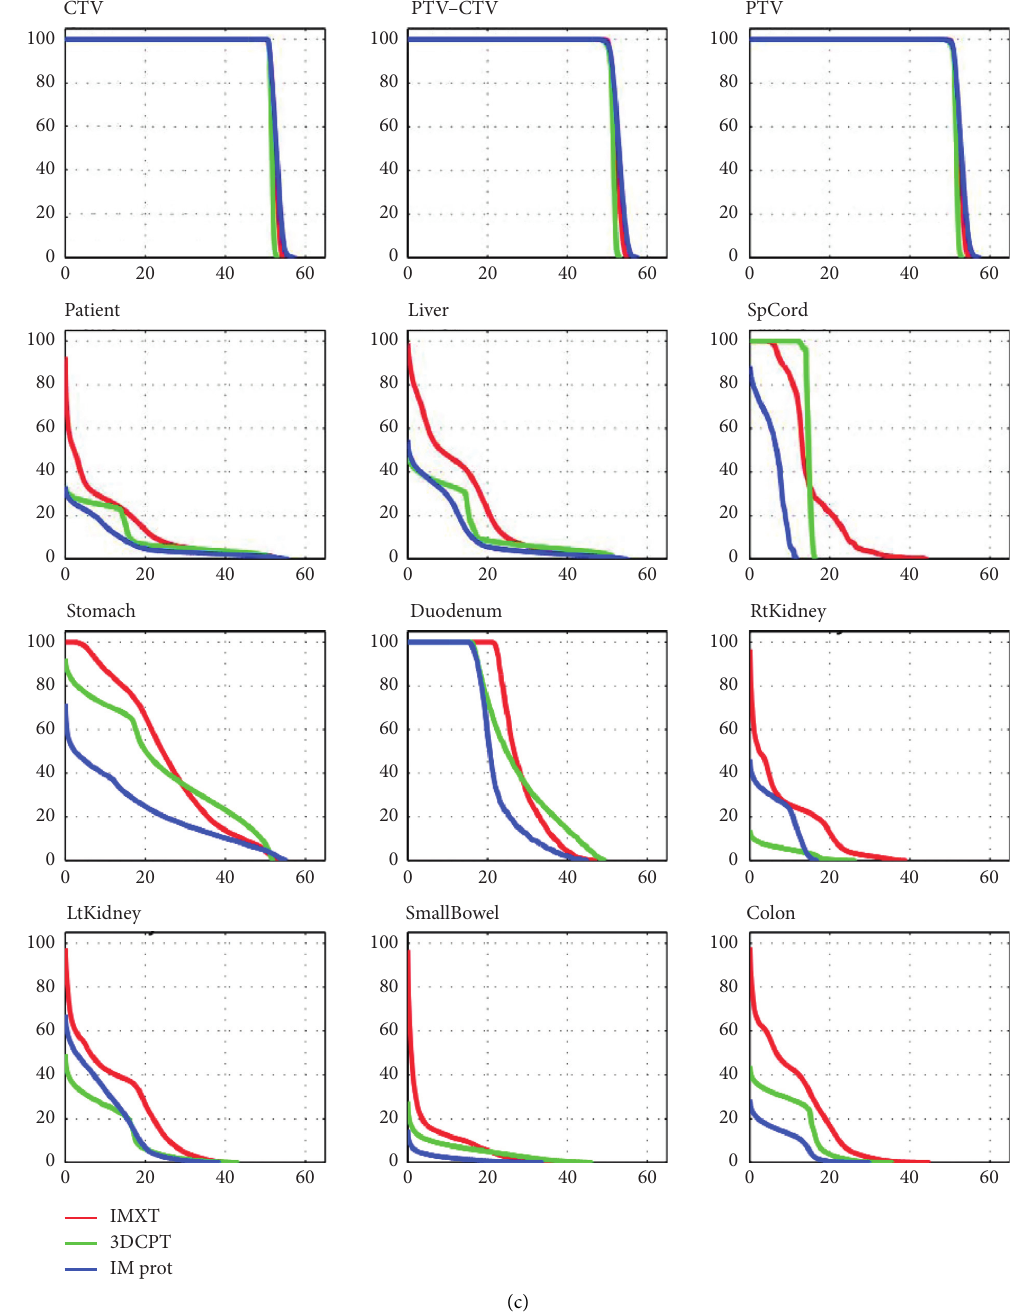
Figure 3: (a) Axial CTslices with isodose lines comparing IMXT, 3D CPT, and IMPTfor myxoid liposarcoma patient. (b) Axial and sagittal CTslices with isodose lines comparing IMXT (A) and IMPT boost plan (B) for a myxoid liposarcoma patient. (c) Dose-volume histogram for myxoid liposarcoma